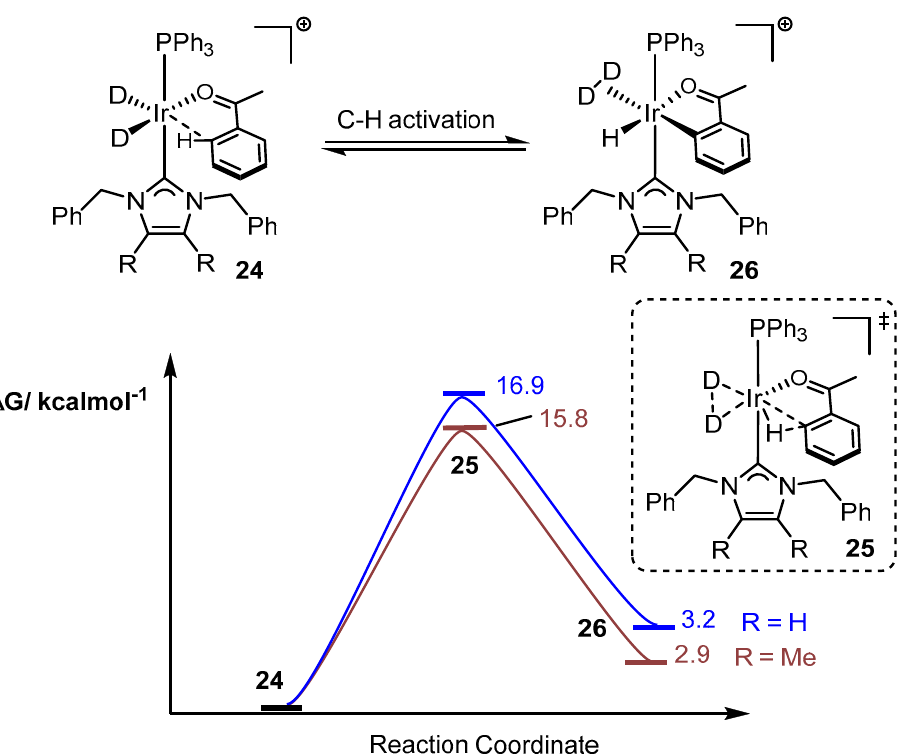
Scheme 6. Computational evaluation of the C-H activation process with catalyst 6a vs. 7 .